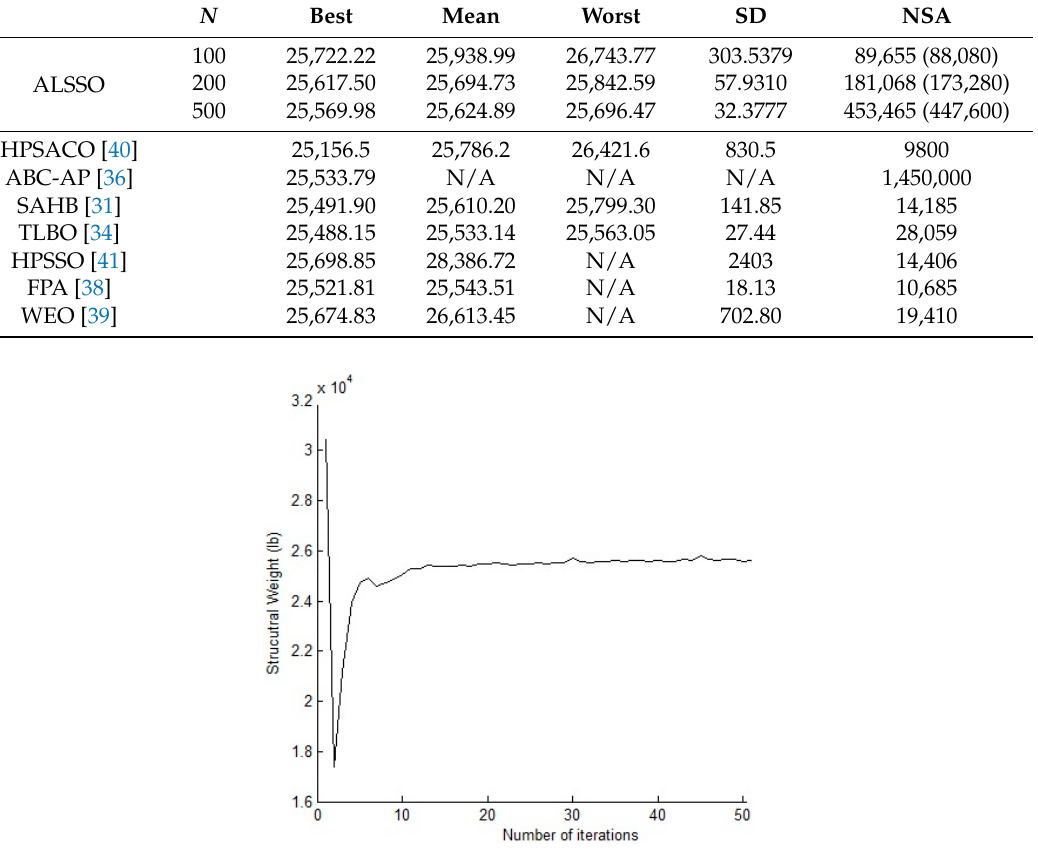
Figure 9. Convergence curve obtained for the 200-bar truss problem with N = 500.